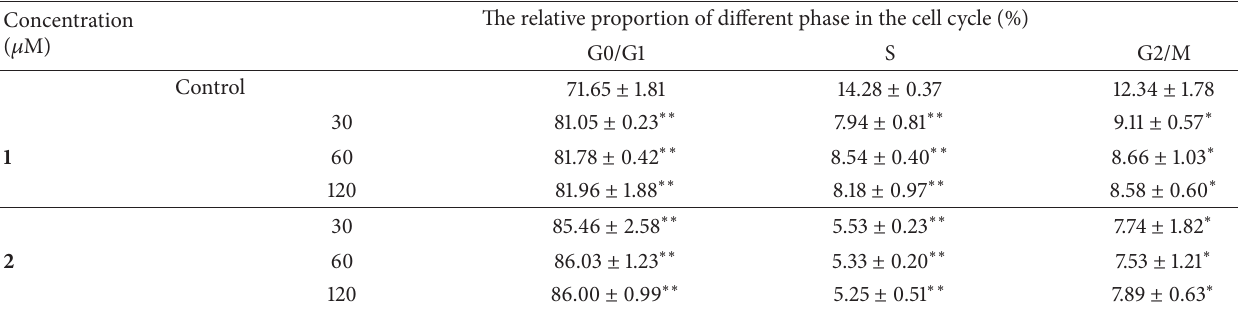
Table 3: The cell cycle analysis of the BEL-7402 cells induced by complexes 1 and 2 for 48h. Concentration The relative proportion of different phase in the cell cycle (%) G0/G1 S G2/M